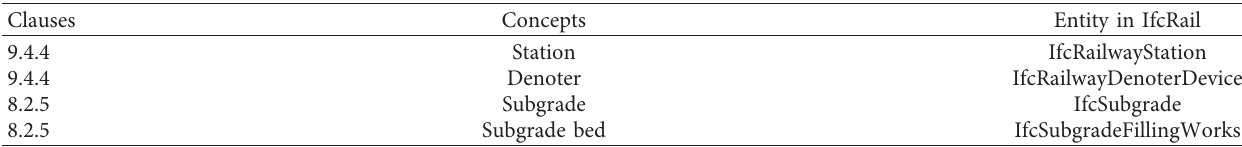
Table 3: Entity extension content mapping